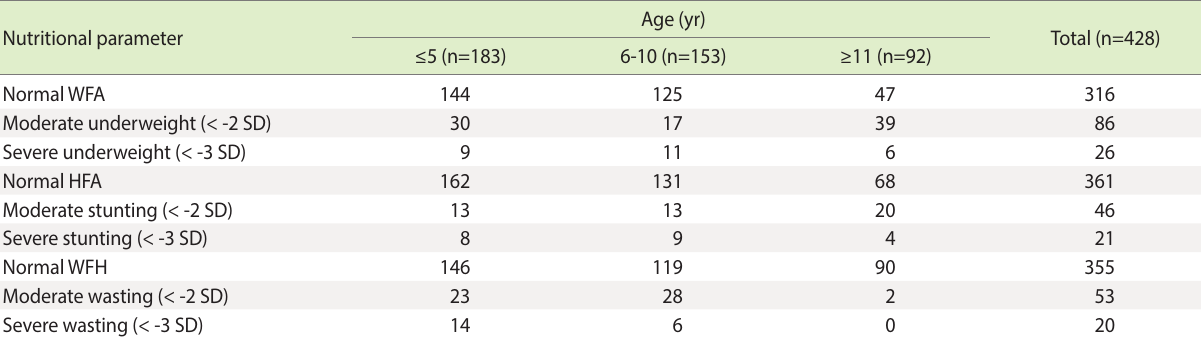
Table 3. Baseline nutritional status of HIV-positive children categorized by age at Adama Referral Hospital and Medical College Nutritional parameter Normal